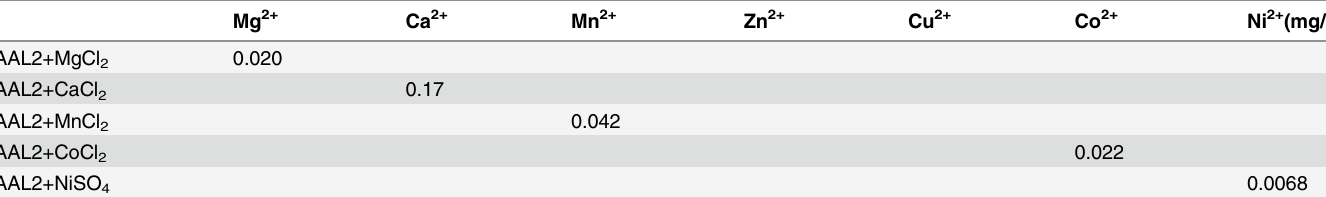
Table 4. Metal content of AAL2 samples prepared with various divalent metal